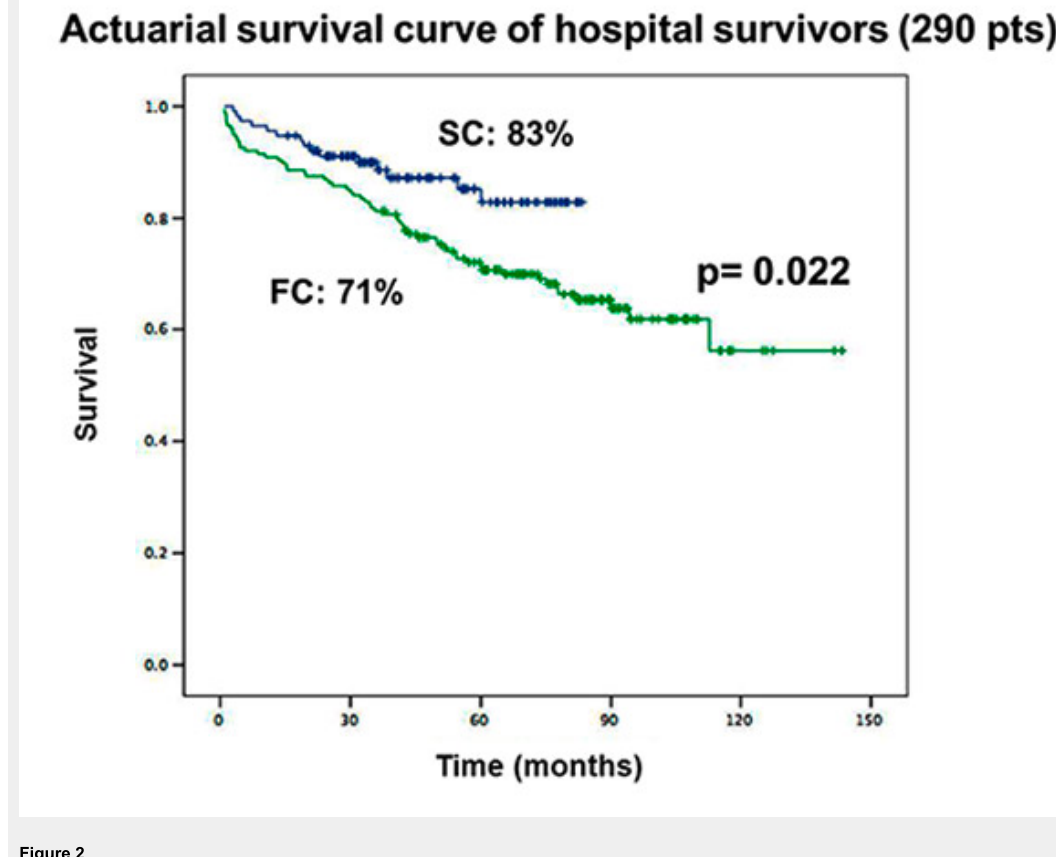
Figure 2 Actuarial survival of hospital survivors (290 patients); SC: blue; FC: